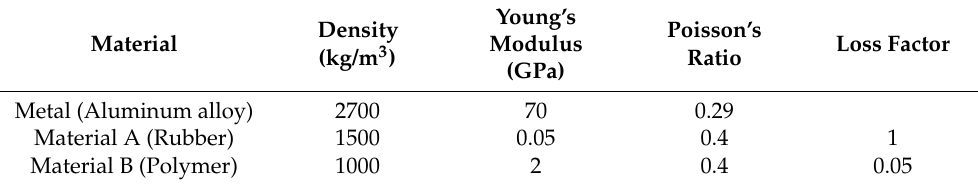
Table 1. Material properties of base material and the two different damping